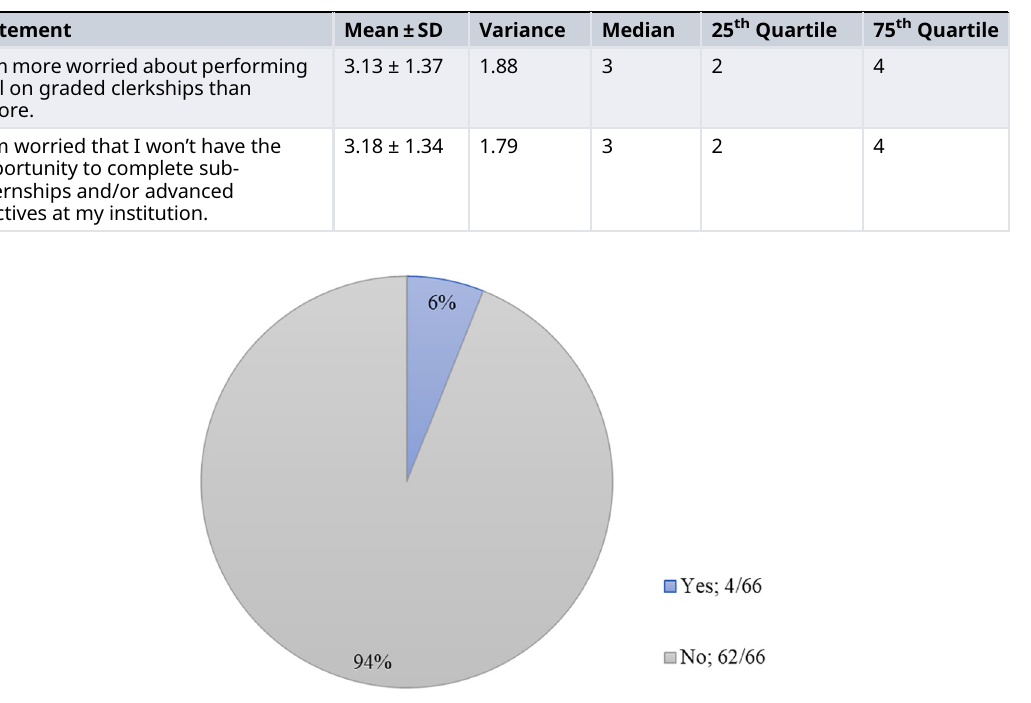
Figure 1. Have you considered changing your preferred specialty choice since the onset of the COVID-19